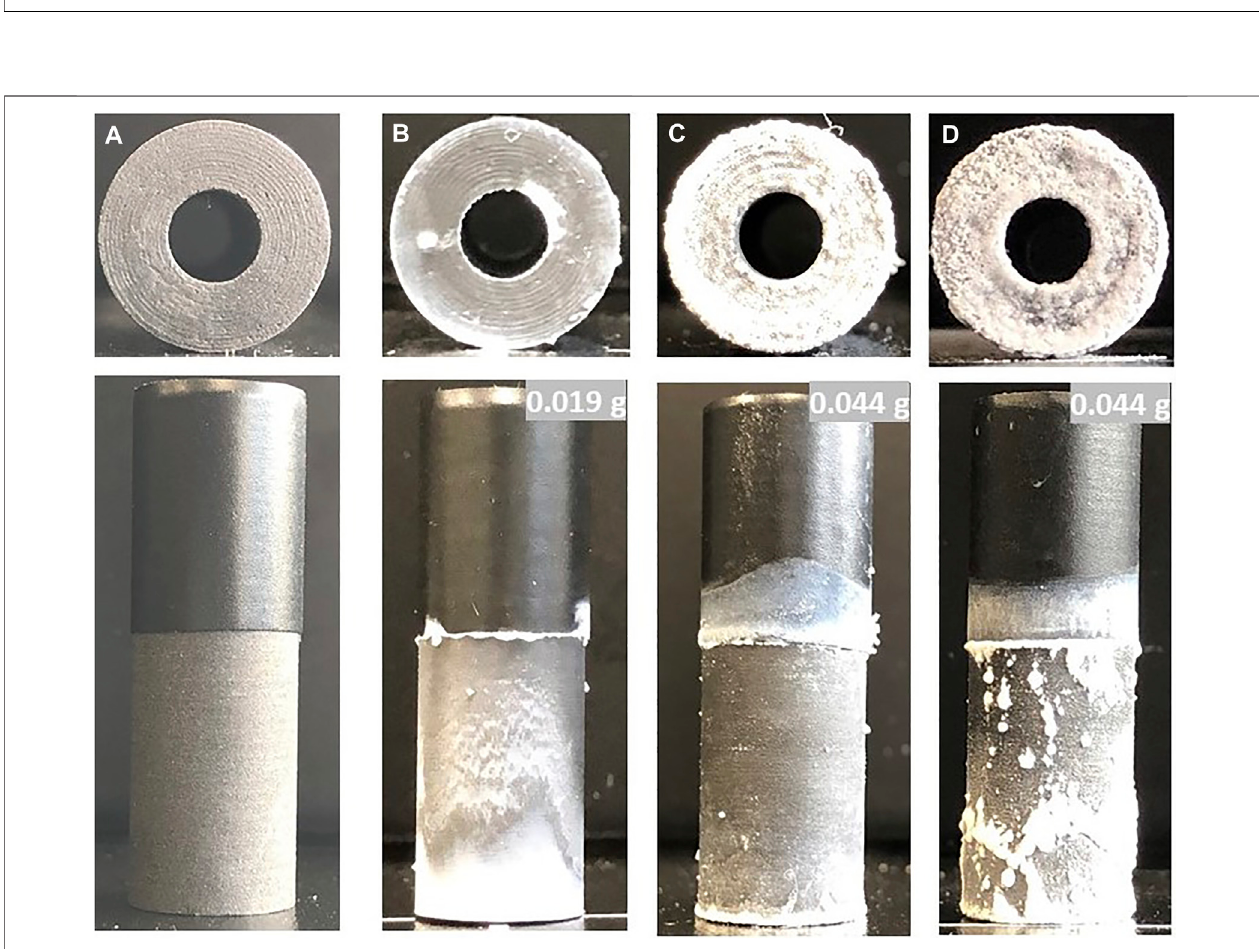
FIGURE 9 | Photos of cathodic graphite tubes before (A) and after (B – D) exposing them for 30 min of polarization (5 V) to synthetic Sognefjord formation water at room temperature (22.3 ° C). The cathode graphite tubes B (solution was stirred) and C (solution was not stirred) are covered with white layers of minerals. In both experiments,theanodewasagraphitetubewithadiameterof2.8 mm.In (D) ,weusedthesamegraphitetubeasanode.Thegraphitetubehasadiameterof1 cmanda length of 3 cm. The numbers shown in the top right corner indicate the weight increase in grams after the experiment.